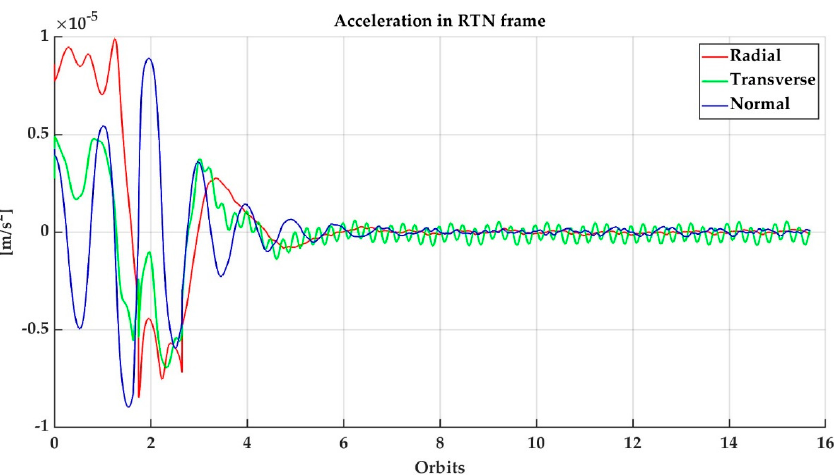
Figure 8. Control acceleration for the follower 1—chief formation, where red is the Radial, green is the Transverse, and blue is the Normal component.